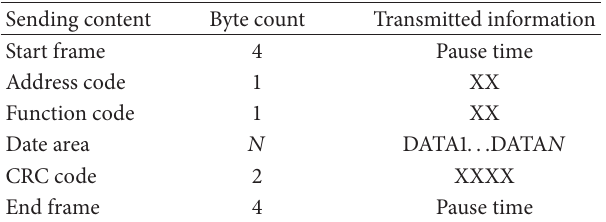
Table 1: The request to read or write a data message format of